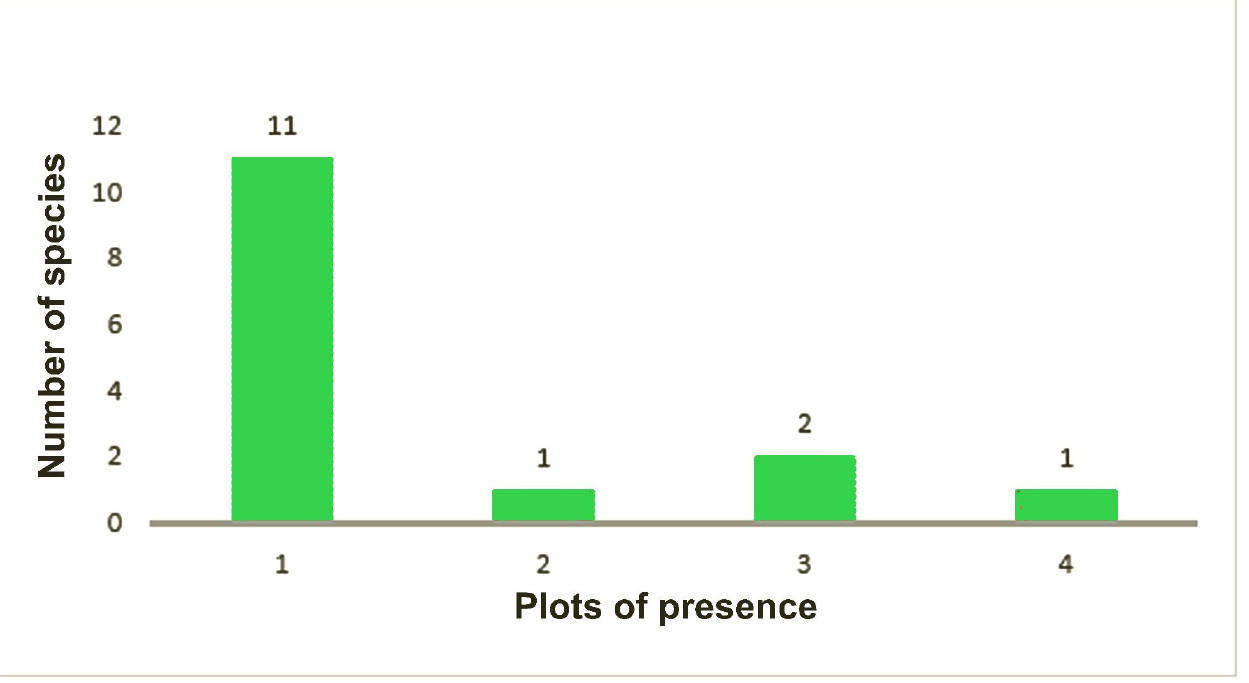
Figure 10. Abundance of species in relation to the number of plots where they have been collected. Otongachi, secondary forest.